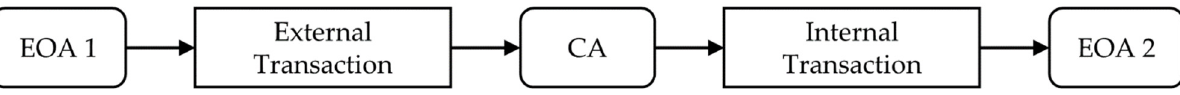
Figure 3. Calling another CA using an internal transaction.